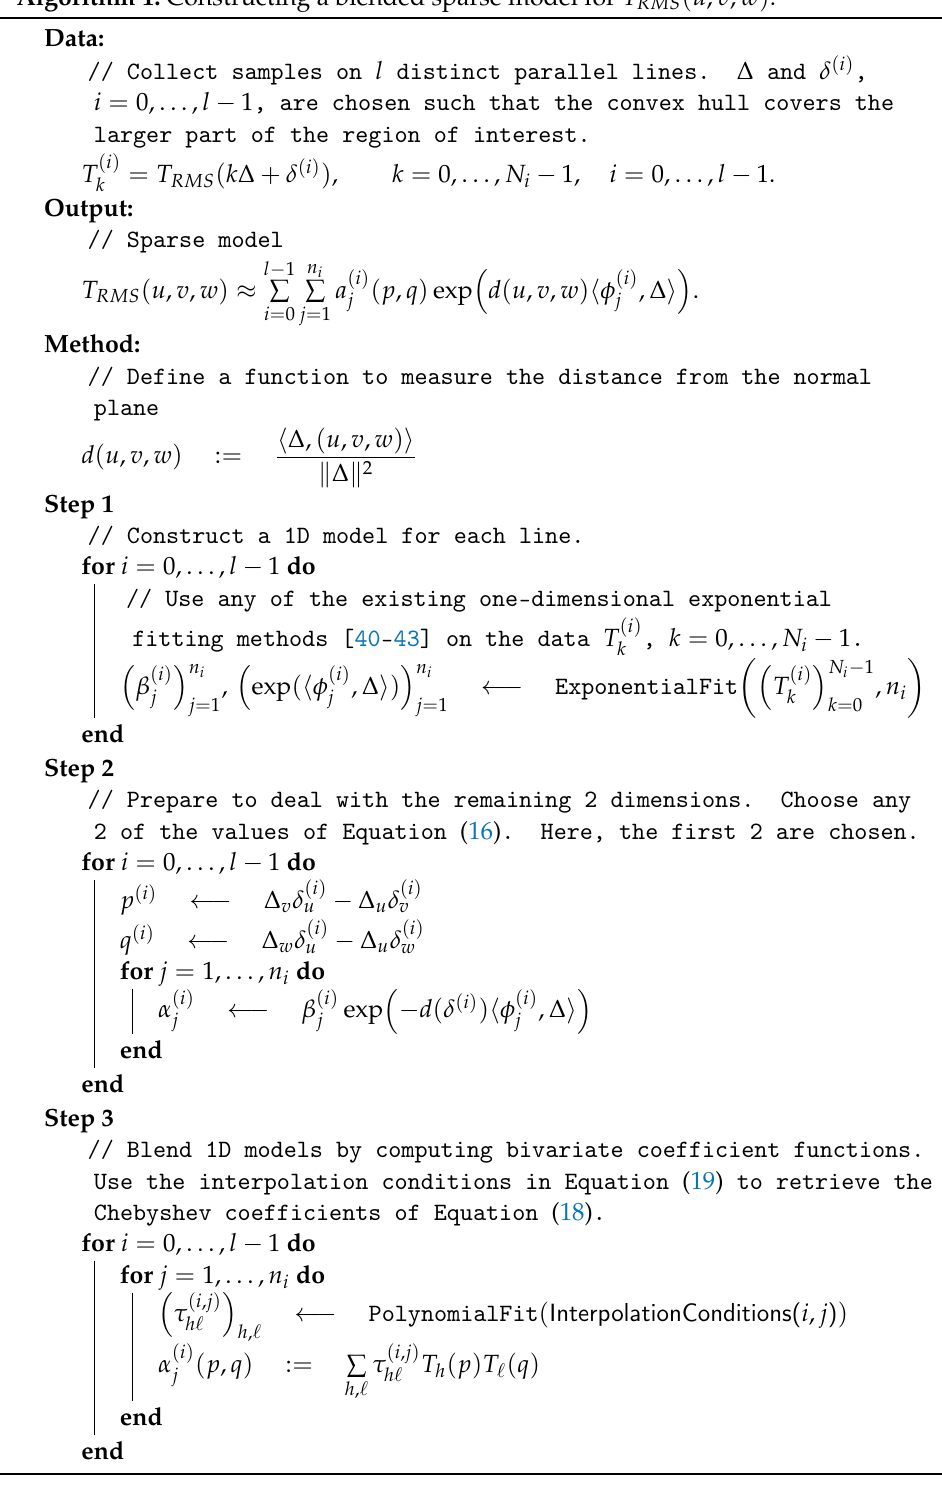
Algorithm 1: Constructing a blended sparse model for T RMS ( u , v , w )